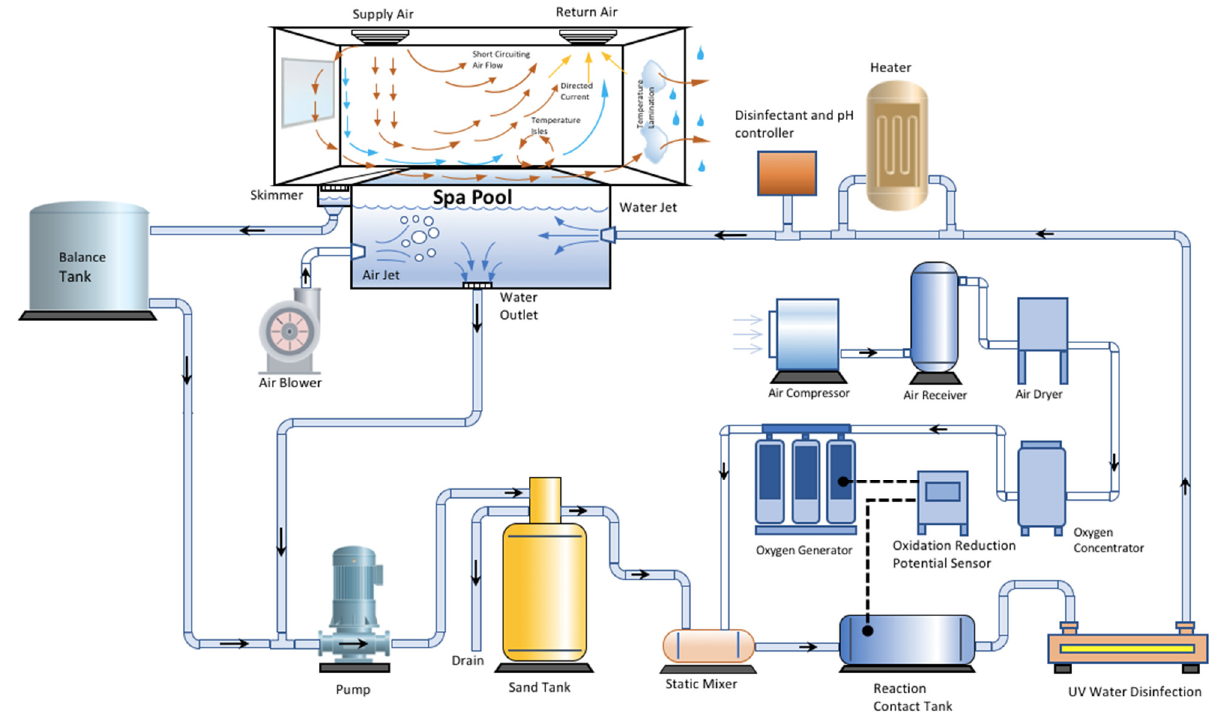
Figure 2. Typical spa pool water treatment system.